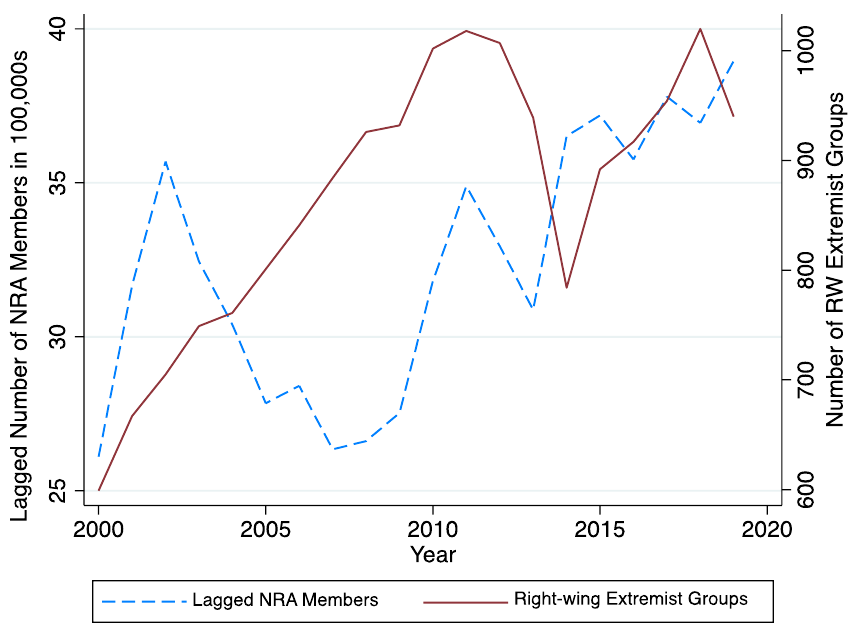
Figure 1: Number of right-wing extremist groups and NRA